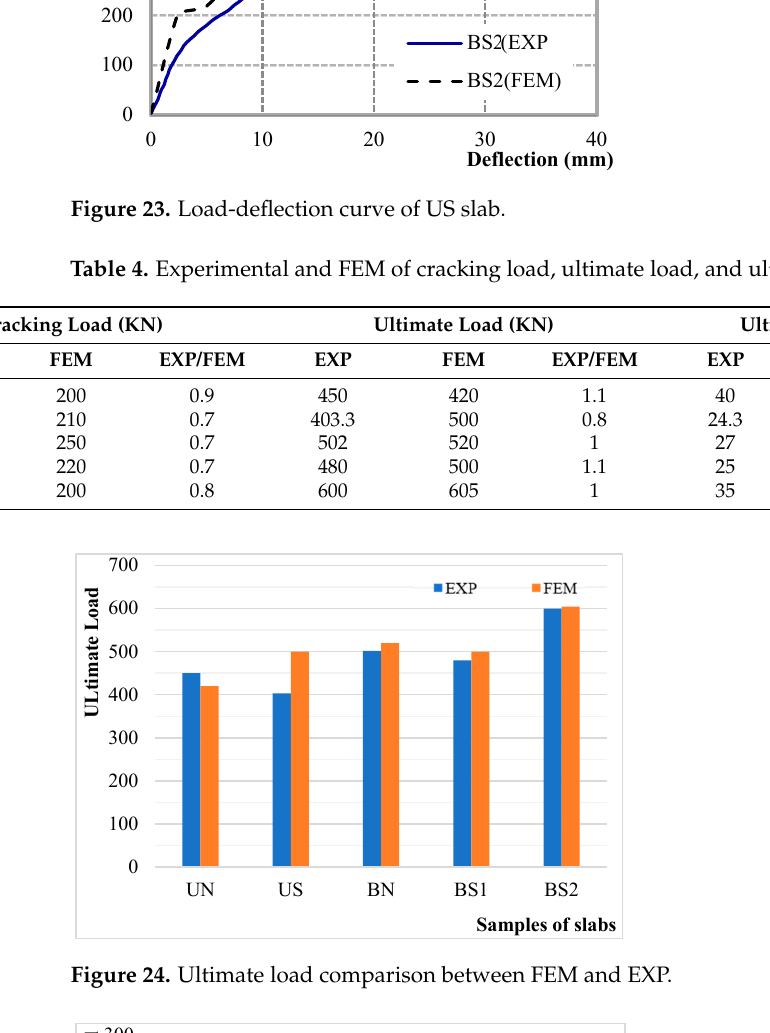
Figure 24. Ultimate load comparison between FEM and EXP.